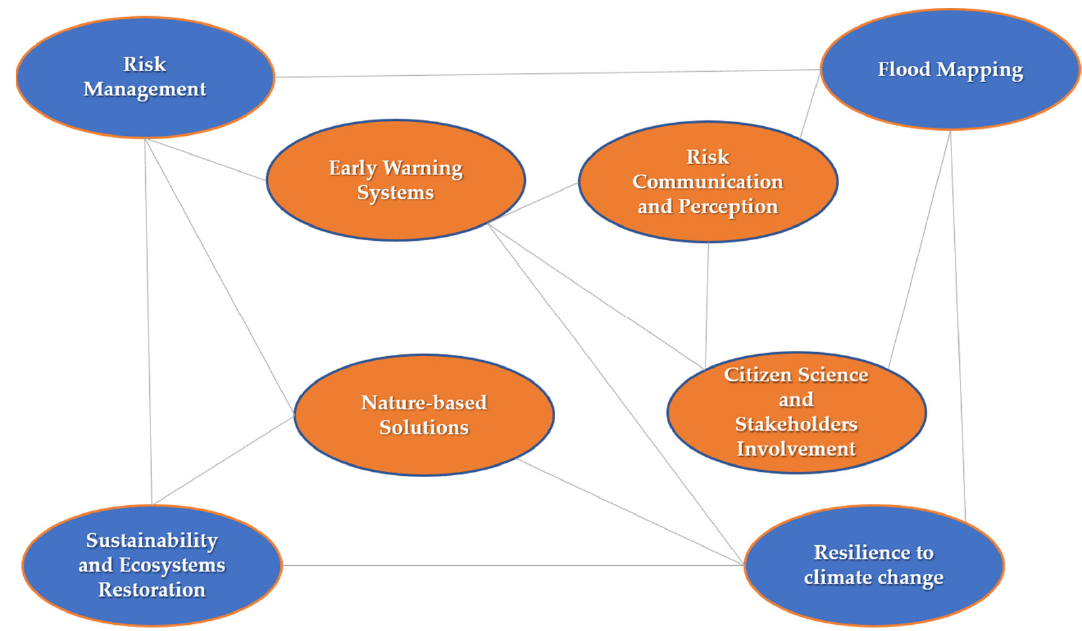
Figure 7. Potential links among research trends in flood ‐ risk management and resilience.